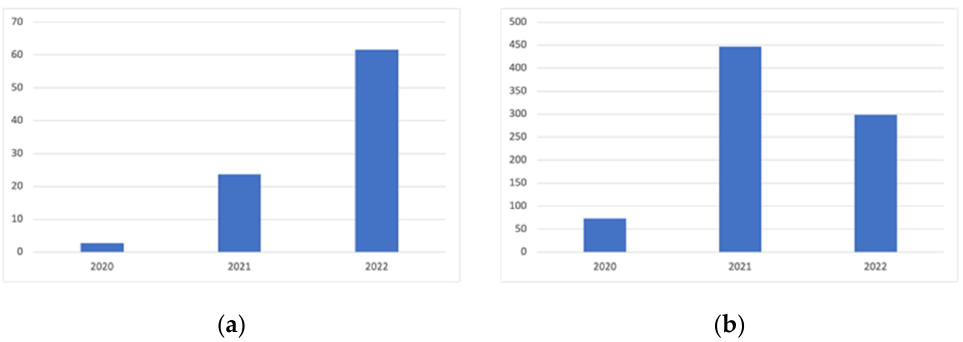
Figure 2. Dynamics on ( a ) publications, and ( b ) citations in the field. Source: Authors’ selection from WoS database, based on selected words, using Excel.